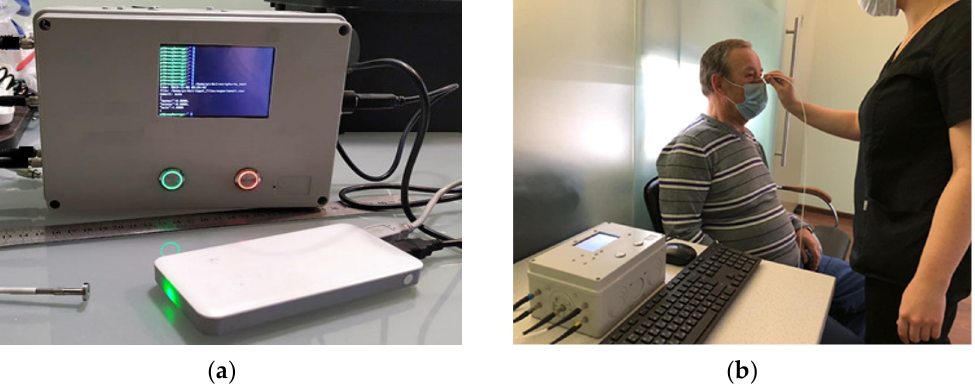
Figure 1. Experimental setup of the DSL-1, where: ( a ) DSL-1 prototyped device; ( b ) Optical bundle of the DSL-1 is placed in gentle contact with the under eyes skin lesion for fluorescence spectra recording.